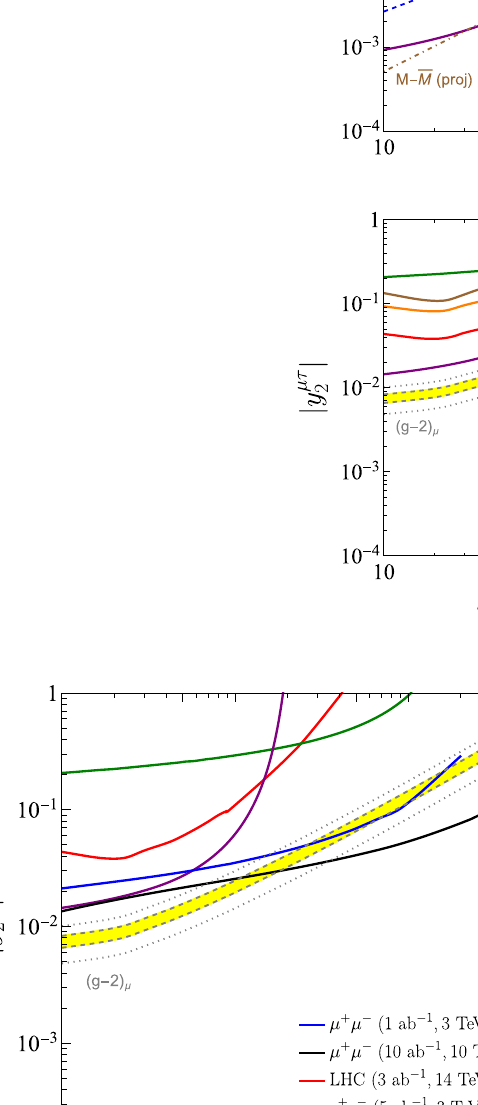
Fig. 3 Projected sensitivity of the colliders to the couplings μ μ y e for h 2 (top left), y e for a 2 2 2 μτ (top right), y (bottom left) 2 and y e τ (bottom right), as 2 labeled in Fig. 2